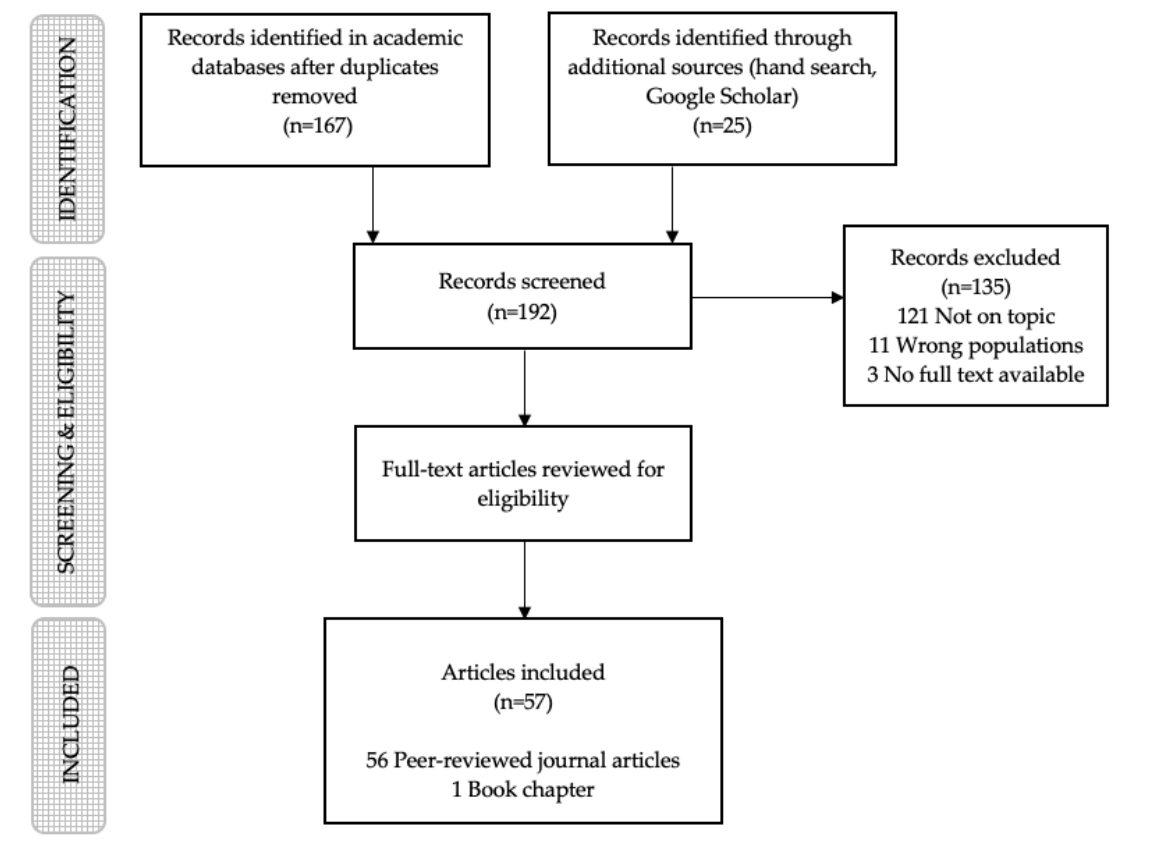
Figure 1. Literature search flow chart.